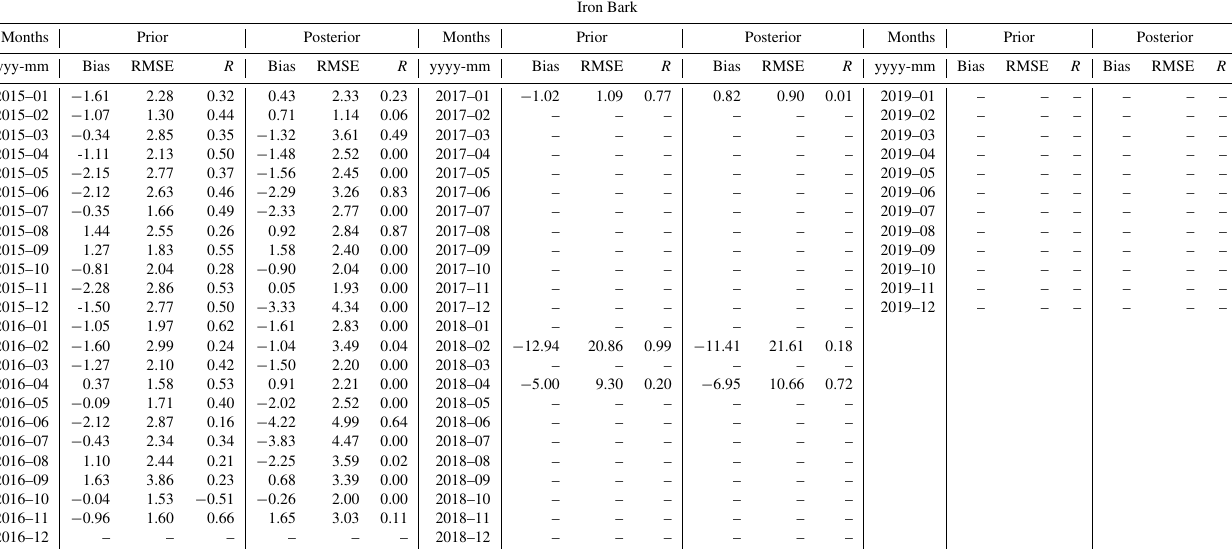
Table G3. Analysis of the residual between CMAQ prior and posterior simulation values and the Iron bark site for the 2015–2019 period, showing the averaged bias (Bias), root-mean-square error (RMSE), and Pearson coefficient ( R ). Iron Bark Months Prior Posterior Months Prior Posterior Months Prior Posterior yyyy-mm Bias